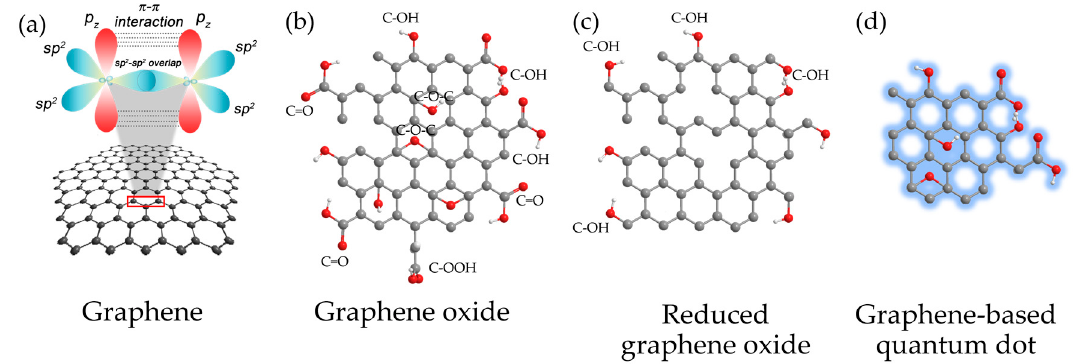
Figure 2. Structures of graphene-based materials show ( a ) the pristine graphene (pure-arranged carbon atoms) with sp 2 -hybridized carbon atoms, and the chemically modified graphene, including ( b ) graphene oxide (GO); ( c ) reduced graphene oxide (RGO) and ( d ) graphene quantum dot (GQD).